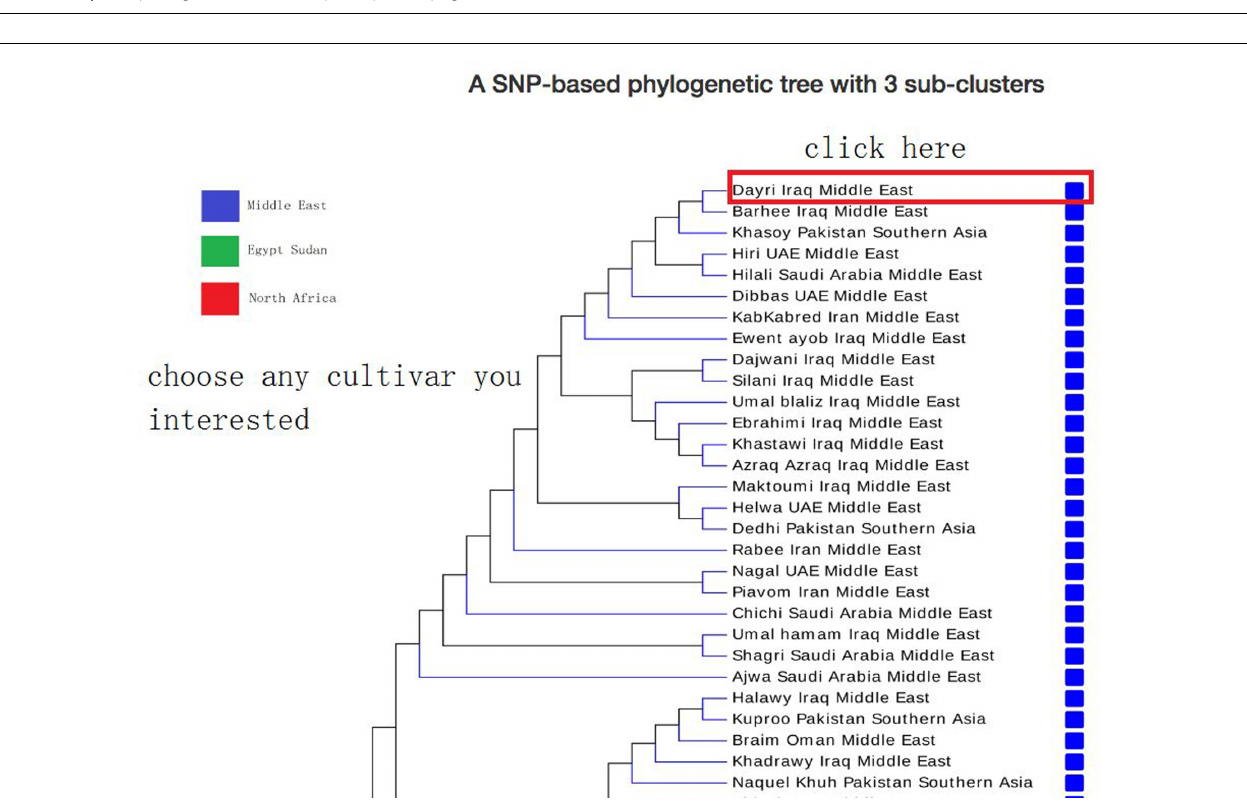
FIGURE 4 | Date palm genome database (DRDB) home